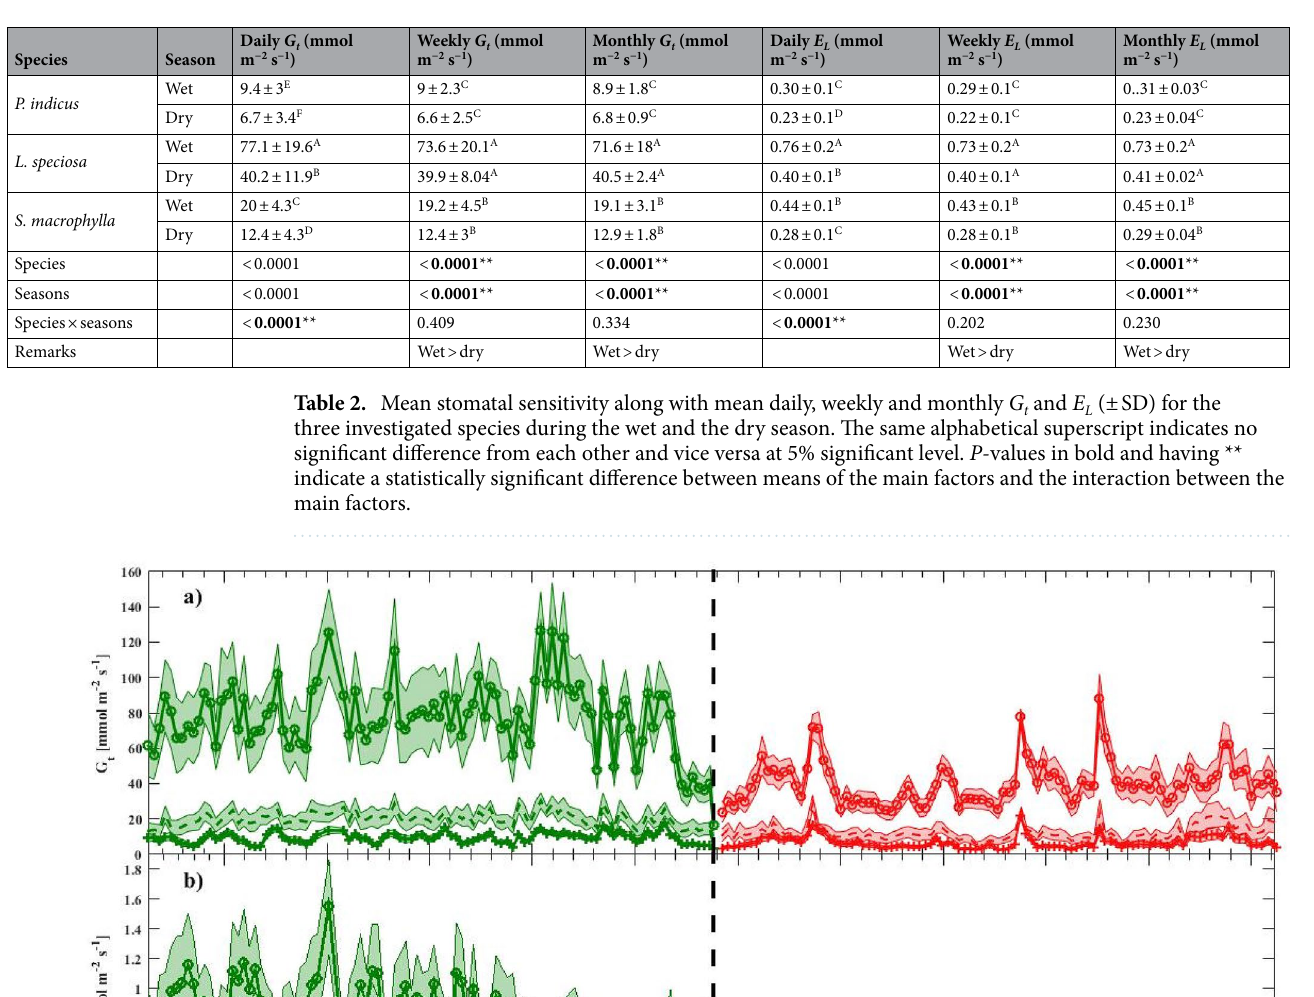
Figure 2. Estimated daily averaged ( a ) canopy conductance ( G t ) and ( b ) leaf transpiration ( E L ) during the wet (green) and dry (red) season. The vertical dash line indicates the ending of the wet season (DOY 305 or November 1st, 2017). Plots for P. indicus are depicted in + −, L. speciosa in o-, and S. macrophylla in—markers, respectively. The shaded regions represent the 95% confidence intervals. This figure was generated